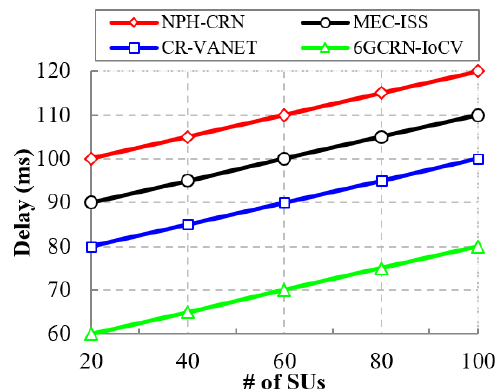
Figure 11. Delay vs. the number of